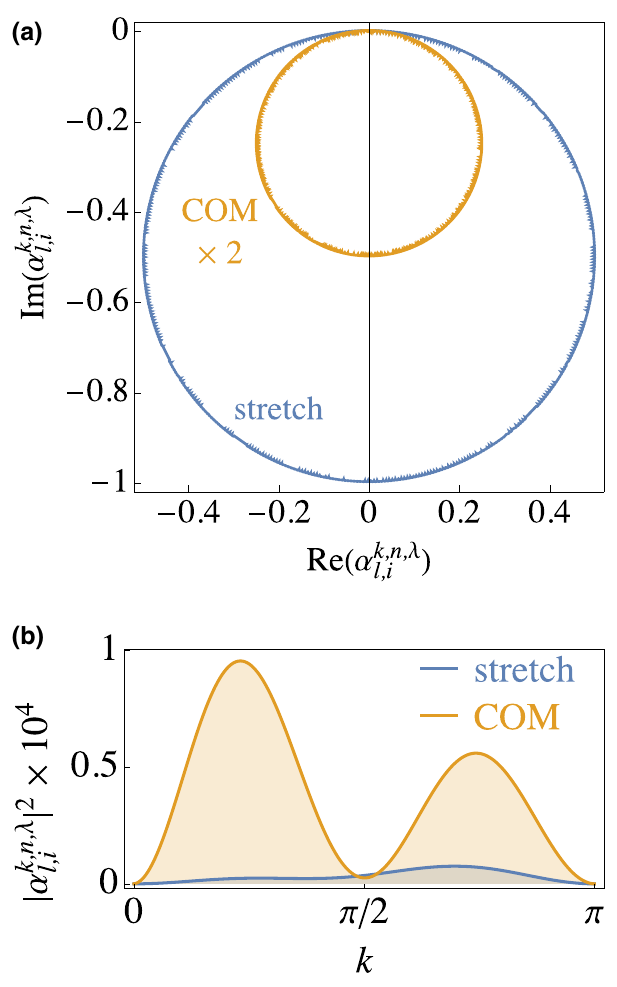
FIG. 4. Phase-space trajectories for parallel entangling gates in an infinite chain. (a) Contribution to the displacement of the phonon mode k , n , λ due to its coupling, Eq. (5), to the qubit at position l = i = 1, which is assumed to be in the + 1 eigenstate . For the chosen detuning close to μ stretch in Eq. (19), the of σ x l , i stretch mode with n = λ = 2 and k ≈ 1.55 such that ω k ,2 = ω 2 equals the mean frequency of the stretch band experiences the strongest displacement. The phase-space trajectory of the COM mode with the same values of k and λ forms a smaller cir- cle, which is traversed twice. Trajectories of modes with n ≥ 3 are not visible on the scale of the figure. (b) Closer inspection reveals that the phase-space curves for different values of k are not perfectly closed. The area under the squared modulus of the qubit-phonon coupling at the end of the gate operation, shown here for n = λ = 2, determines the infidelity (11). Parameters of the ion chain are p = 6, ν 0 = 0.4, and (cid:14) = 0.07. = χ 0 Rabi frequency is chosen such that χ i , i (cid:3) i , i (cid:3)